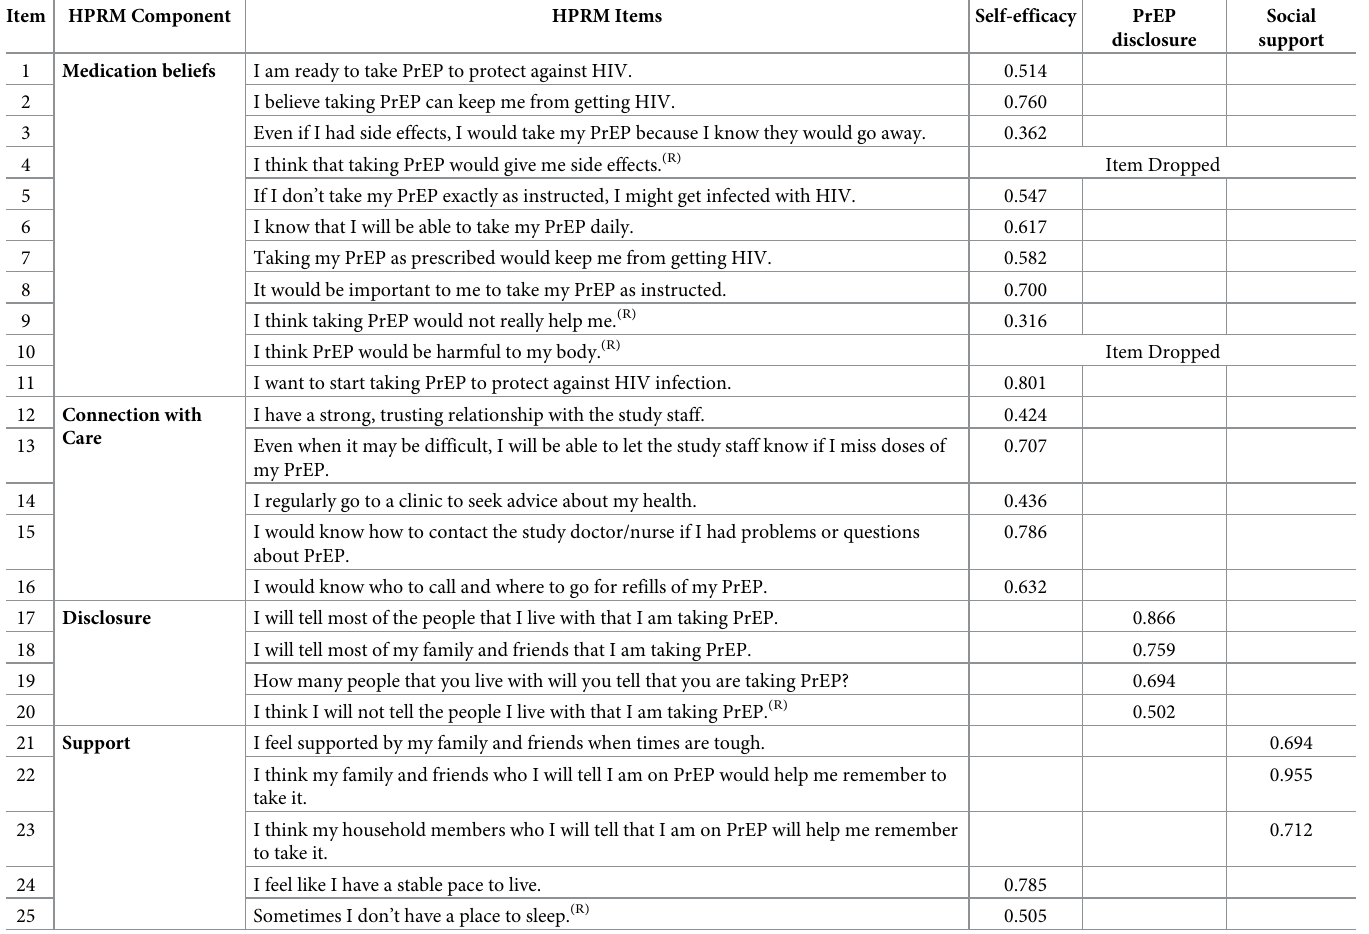
Table 1. HPRM components and exploratory factor analysis